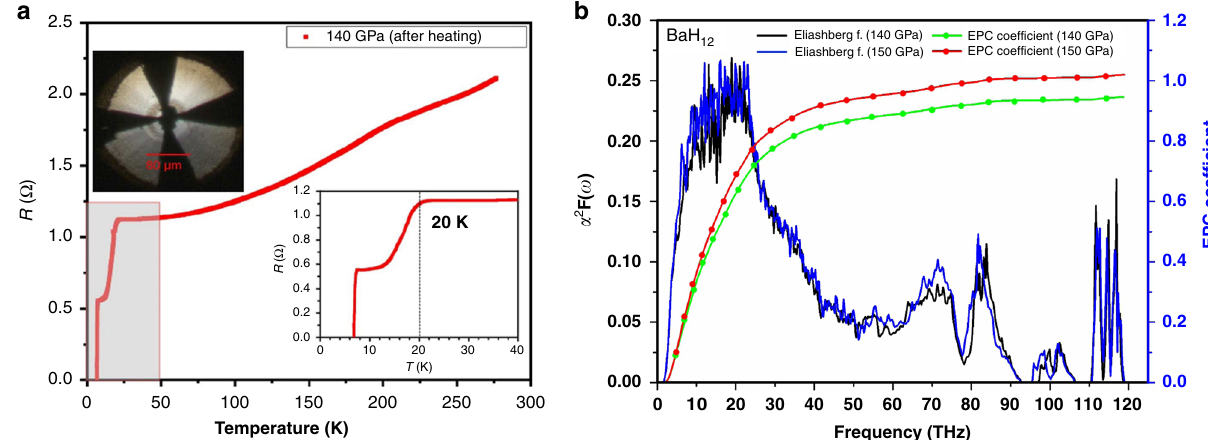
Fig. 5 Electrical measurements and calculations of superconducting properties. a Four-probe measurements of the electrical resistance R ( T ) of the BaH x sample synthesized using the laser heating at 140 GPa. The superconducting transition was detected at ~20 K. b Calculated Eliashberg spectral functions and electron-phonon coupling parameter ( λ ) for pseudocubic BaH 12 at 140 (black) and 150